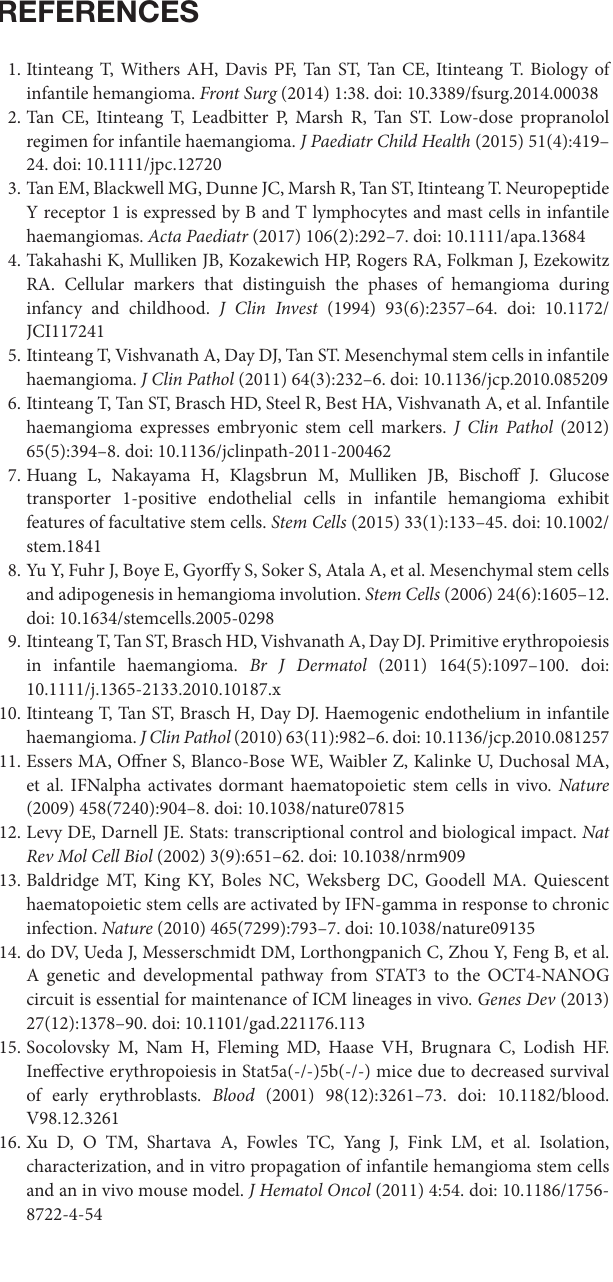
Figure s3 | Representative Western blot images of 1DE separated total protein extracts of positive controls human tonsil demonstrating the presence of pSTAT1 detected as a single band at 91 kDa (a) , mouse lung demonstrating the